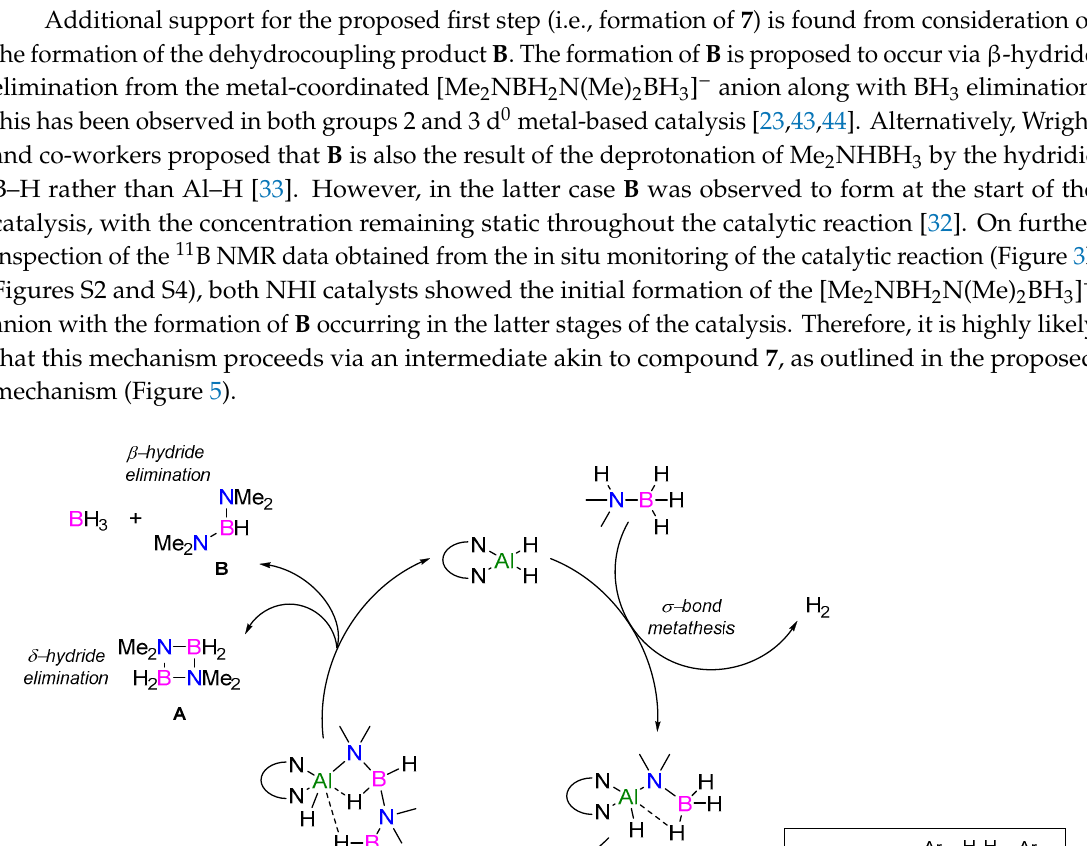
Figure 4. Stoichiometric reduction of Me 2 NHBH 3 with catalyst 1 .